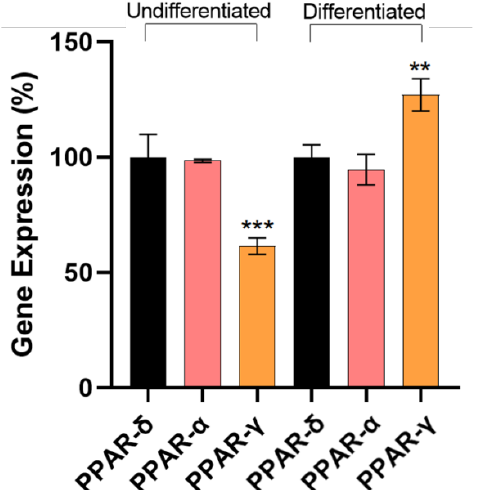
Figure 3. 3T3-L1 cell differentiation into mature adipocytes. ( A ) Undifferentiated pre-adipocytes (20× objective); ( B ) Differentiated adipocytes (20× objective). ( C – H ) Accumulation of different lipid droplets according to the different pioglitazone levels: 0, 1, 2.5, 5, 7.5, and 10 µM, respectively (10× objective).